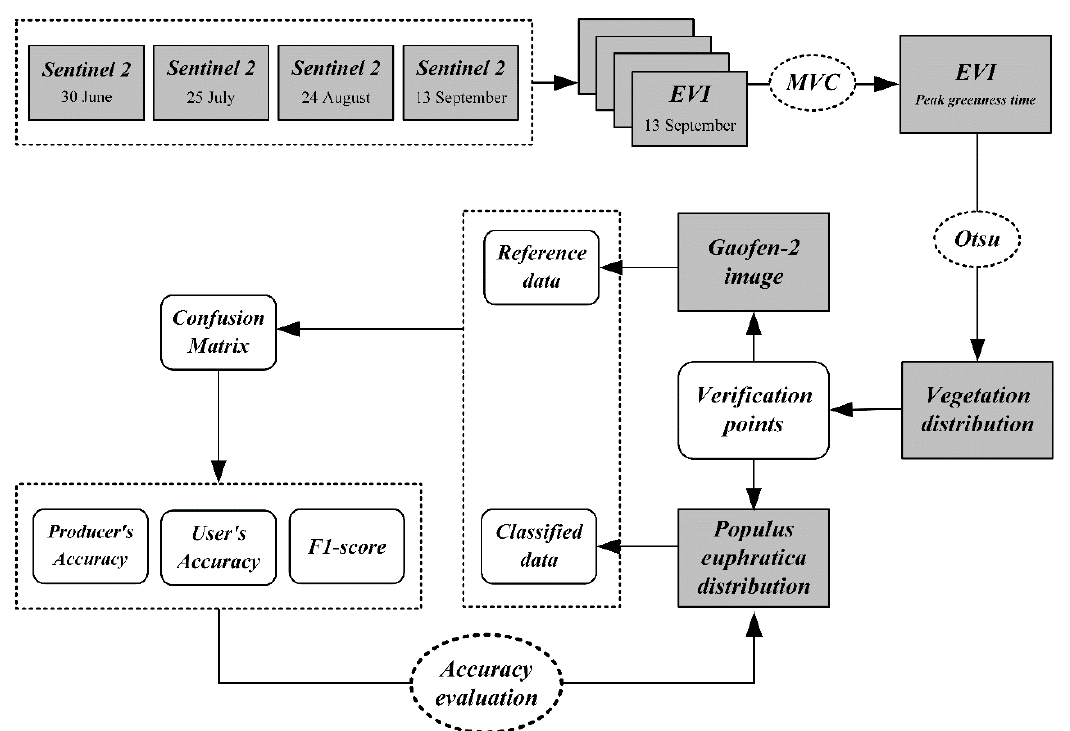
Figure 3. Flowchart of the accuracy evaluation. MVC, maximum value